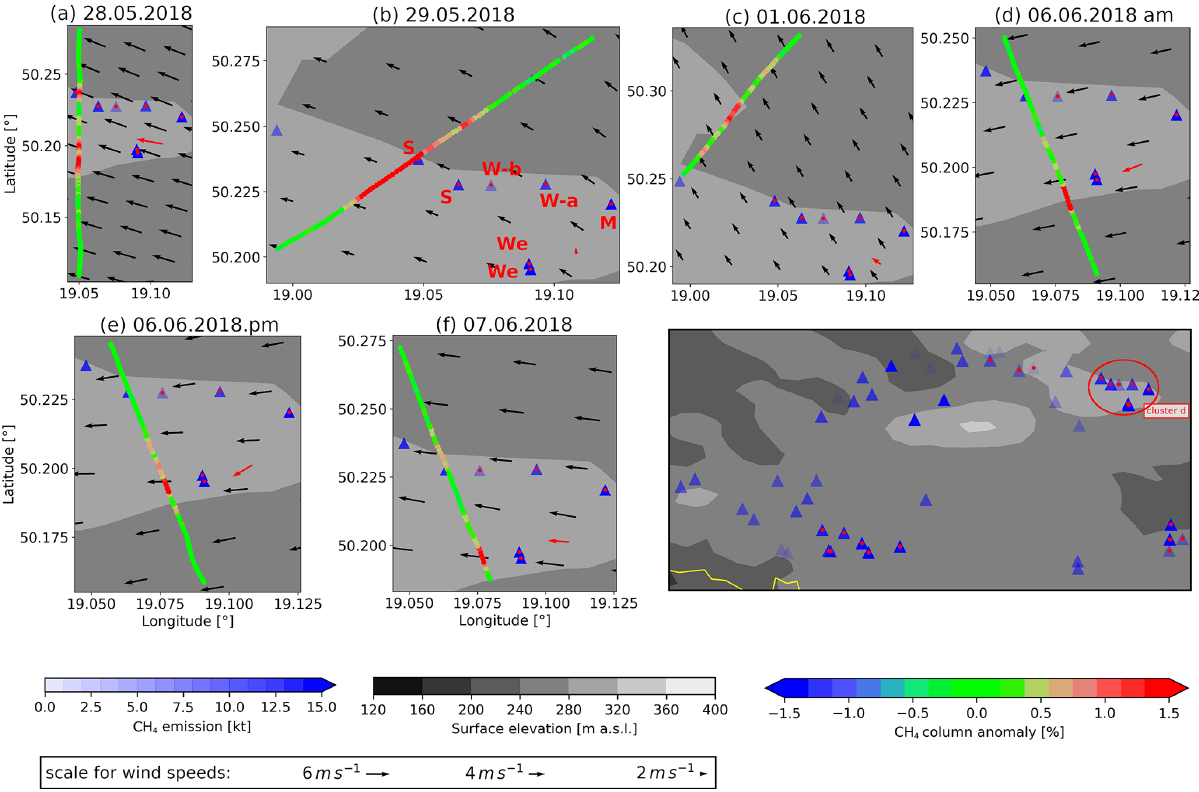
Figure C6. Same as Fig. 5 but for shaft cluster d in the north-eastern part of the study area (S: Staszic, W-b: Wieczorek-b, W-a: Wieczorek-a, M: Mysłowice, We: Wesoła). The corresponding cross-sectional fluxes are summarized in Table C1, and detailed cross-sections are found in Fig.